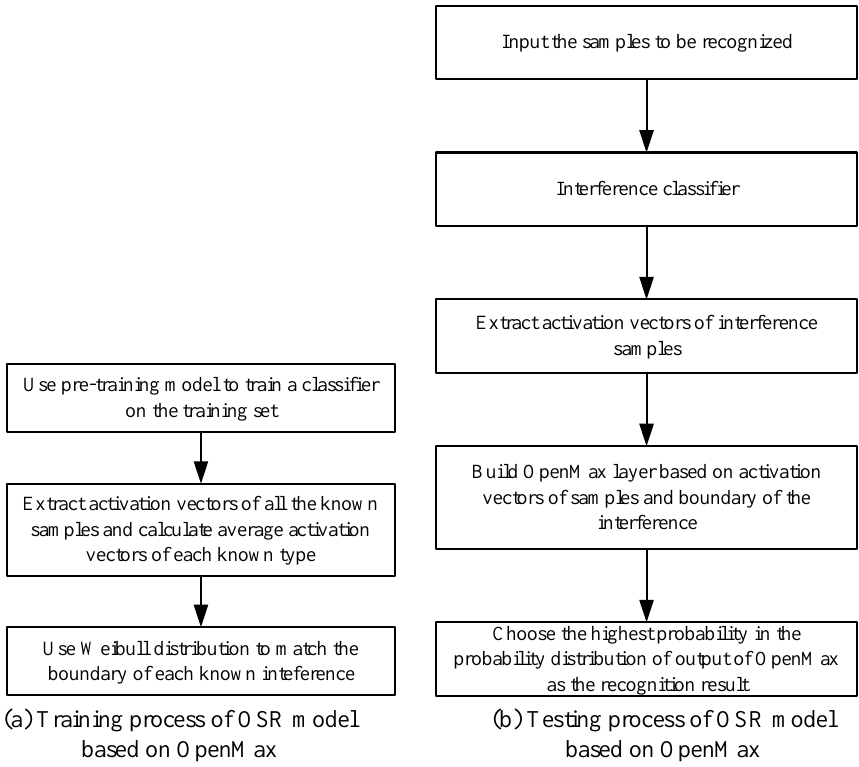
Figure 13. Training and testing process of OSR model based on OpenMax.